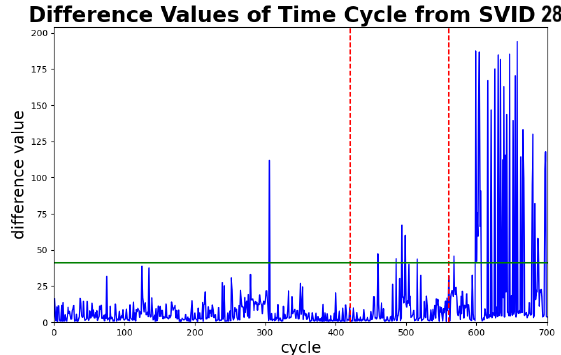
Figure 15. Difference values related to time series for estimating detection speed for the experiment in Section 6.2.